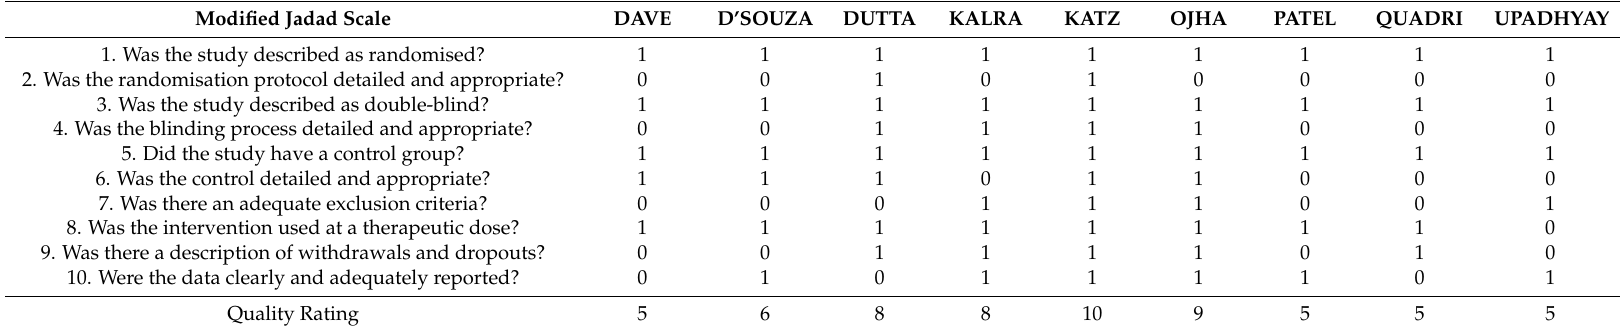
Table 4. Jadad Scale Quality Rating of Included